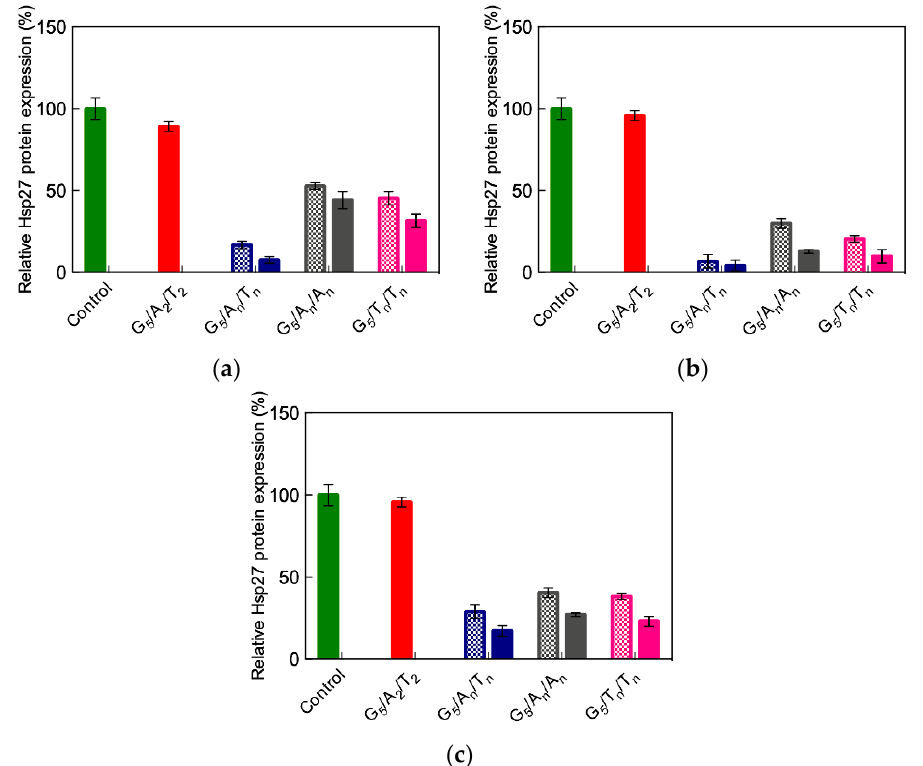
Figure 16. Hsp27 gene silencing upon delivery of different ssiRNAs (50 nM) mediated by G 5 TEA-core PAMAM (N/P = 10) to PC-3 cells ( a ), MDA-MB-231 cells ( b ), and MCF-7 cells ( c ). Checked bars: Data for ssiRNA with n = 5; solid bars: Data for ssiRNA with n = 7. In these experiments, vinculin was used as reference, and non-treated cells were used for control (green solid bar). Data for non-sticky siRNA (A 2 /T 2 ) are also shown for comparison (red solid bar). MDA-MB-231 and MCF-7 are two different breast cancer cell lines. Redrawn from [57], with permission of the American Chemical Society.